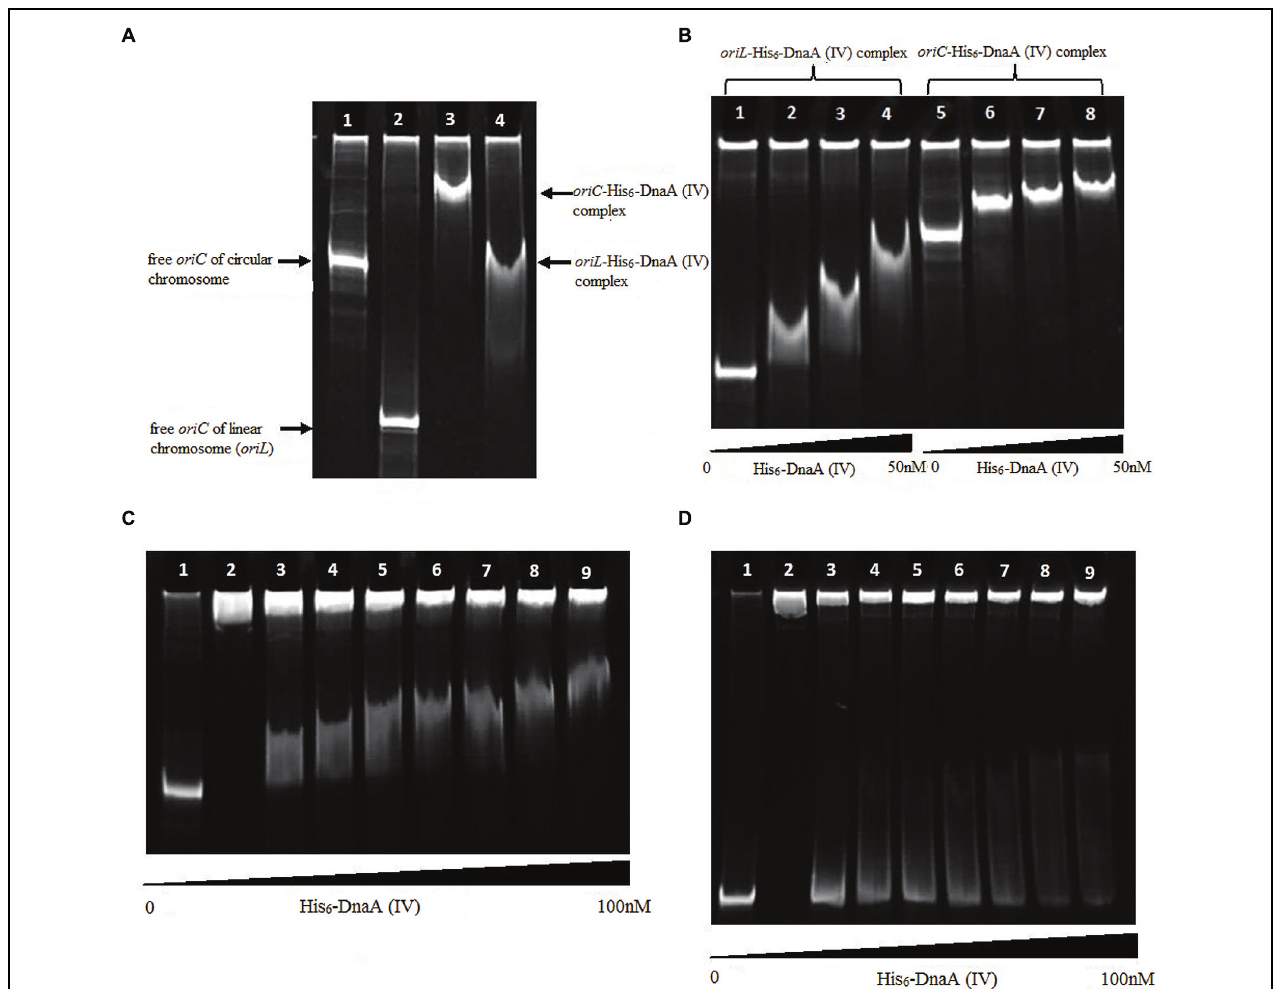
FIGURE 4 | Interaction of the DnaA (IV) protein with the Cyanothece 51142 oriC. (A) Interaction of the DnaA (IV) protein with the Cyanothece 51142 oriC (5% gel). (1) Free oriC fragment of the circular chromosome. (2) Free oriC fragment of of the linear chromosome. (3) His 6 -DnaA (IV) binding to the circular chromosome oriC. (4) His 6 -DnaA (IV) binding to the linear chromosome oriC. (B) Interaction of the DnaA (IV) protein with the Cyanothece 51142 oriC (5% gel). (1) Free oriC fragment of the linear chromosome. (2–4) His 6 -DnaA (IV) binding to the linear chromosome oriC (10, 25, 50 nM). (5) Free oriC fragment of the circular chromosome. (6–8) His 6 -DnaA (IV) binding to the circular chromosome oriC (10, 25, 50 nM). (C) Interaction of the His 6 -DnaA (IV) protein with the oriC of the circular chromosome (5% gel). (1) oriC fragment of the circular chromosome [without DnaA (IV)]. (2) His 6 -DnaA (IV) protein (without the oriC fragment). (3–9) His 6 -DnaA (IV) binding to the circular chromosome oriC (3: 2.5; 4: 5.0; 5: 10.0; 6: 25.0; 7: 50.0; 8: 75.0; 9: 100.0 nM). (D) Interaction of the His 6 -DnaA (IV) protein with the oriC of linear chromosome (5% gel). (1) oriC fragment of the linear chromosome [without His 6 -DnaA (IV)]. (2) His 6 -DnaA (IV) protein (without the oriC fragment). (3–9) His 6 -DnaA (IV) binding to the linear chromosome oriC (3: 2.5; 4: 5.0; 5: 10.0; 6: 25.0; 7: 50.0; 8: 75.0; 9: 100.0 nM).